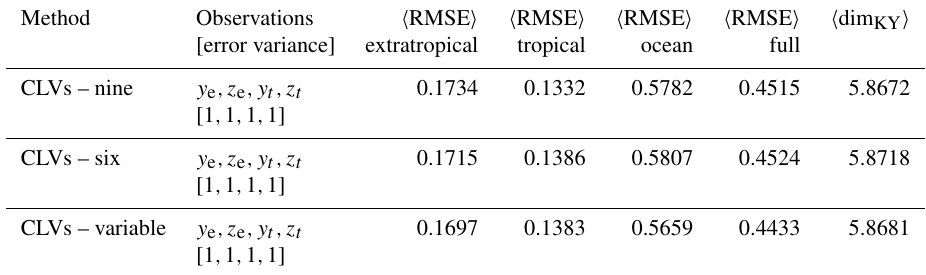
Table 3. Summary metrics of DA experiments using a right-transform matrix (Eq. 15) and atmosphere observations ( y e ,z e ,y t ,z t ). Parame- ters: assimilation window 0.08, inflation factor 1%, 10 ensemble